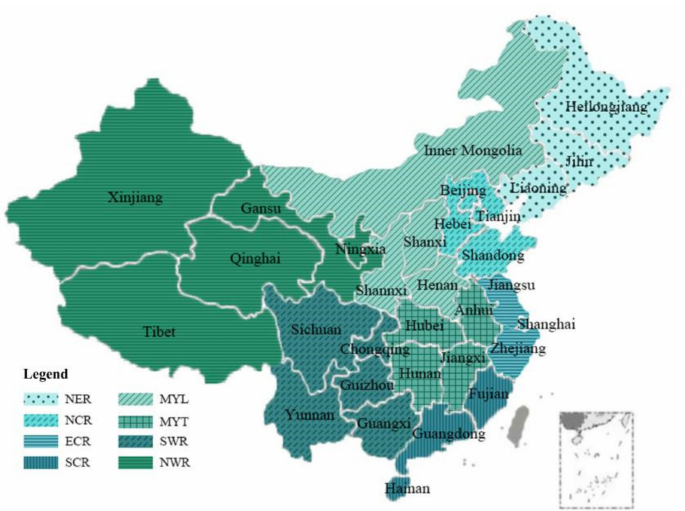
Figure 4. Divisions of China’s economic regions. Note: NER—Northeast Region; NCR—Northern Coastal Region; ECR—Eastern Coastal Region; SCR—Southern Coastal Region; MY—LMiddle Reaches of Yellow River; MYT—Middle Reaches of Yangtze River; SWR—Southwest Region; NWR— Northwest